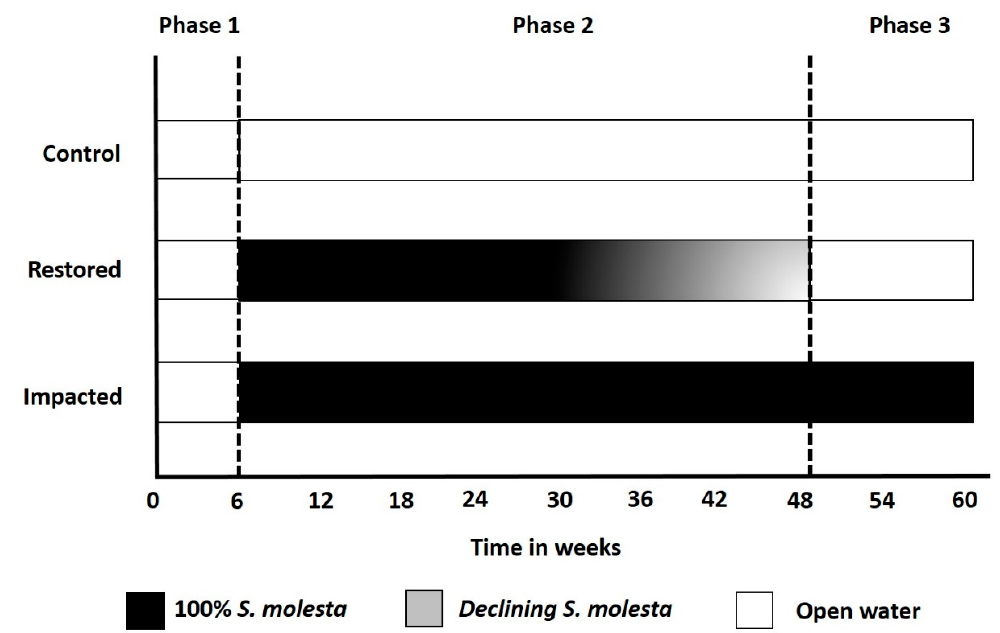
Figure 1. A before–after control–impact (BACI) mesocosm experiment design and timeline, representing three treatments: impacted (100% Salvinia molesta ), restored ( Salvinia molesta and Cyrtobagous salviniae ), control (open water control), and three invasion phases: phase 1 (“before” invasion), phase 2 (“during” invasion), and phase 3 (“after” biological control).